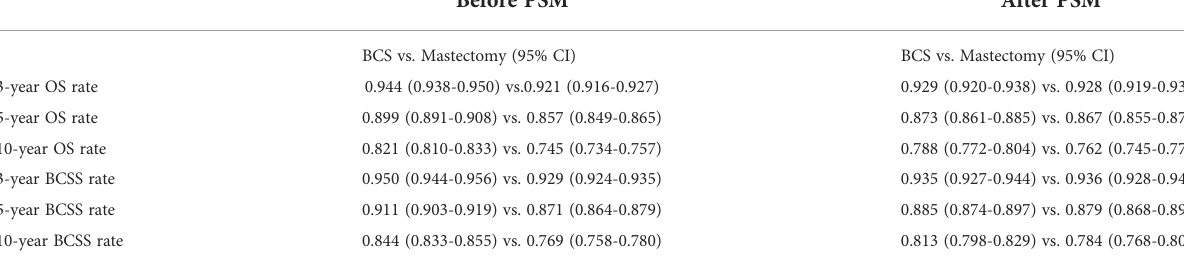
TABLE 2 Comparison of patient survival rates between the two surgery groups before and after PSM. Before PSM After PSM BCS vs. Mastectomy (95% CI) BCS vs. Mastectomy (95%